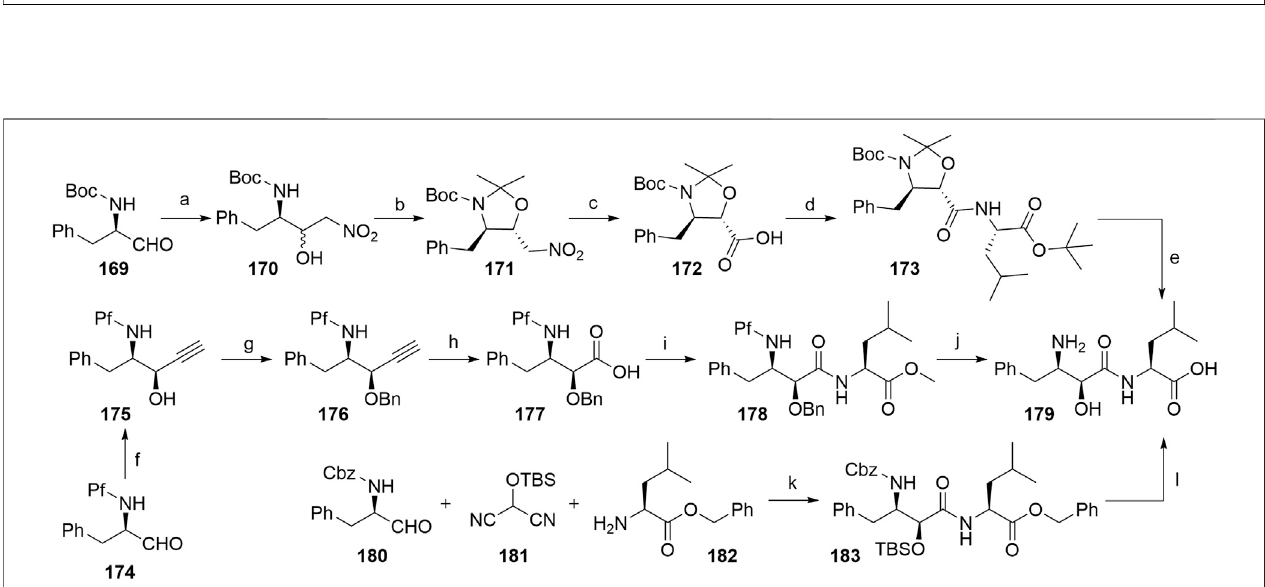
SCHEME 31 | Syntheses of bestatin ( 179 ). Reagents and conditions: a) nitromethane, NaH, 15-crown-5, EtO 2 , hexane, 0 ° C to rt, 22 h, 64% yield; b) 2,2- dimethoxypropane, BF 3 × OEt 2 , 0 ° C, 1 h, then rt, overnight, 54% yield; c) KOH, KMnO 4 , Na 2 HPO 4 , MeOH, H 2 O, 0 ° C, 2 h, quant.; d) isobutyl chloroformate, NMP, THF, 0 ° C to – 12 ° C, 30 min, then L -leucine tert-butyl ester, NMP, DMF, – 12 ° C, 90 min, 69% yield; e) TFA, H 2 O, 0 ° C, 2.5 h, quant. (Shang et al., 2018); f) ethynylmagnesium bromide, THF, – 40 ° C, 10 min, 96% yield; g) BnBr, NaH, Bu 4 NI, THF, 0 ° C, 97% yield; h) KMnO 4 , AcOH, H 2 O, pentane, 87% yield; i) L -leucine methyl ester, DCC, HOBt, TsOH, Et 3 N, THF, 0 ° C, 91% yield; j) i. LiOH, THF, H 2 O, 0 ° C, 95% yield; ii. Pd/C, H 2 , MeOH, 50 ° C, 93% yield (Lee et al., 2003); k) 4-pyrrolidinopyridine, Et 2 O, 0 ° C, 5 h, diastereomeric mixture in 80% yield, 79:21 ratio; l) i. Bu 4 NF, THF, 0 ° C, 20 min, 96% yield; ii. Pd/C, H 2 , MeOH, rt, 2 h, quant (Nemoto et al., 2000).